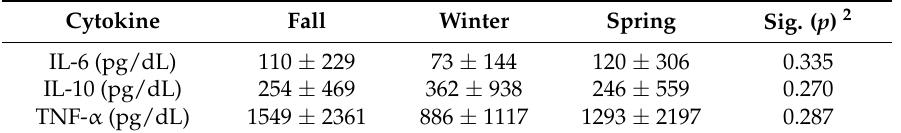
Table 3. Cytokine concentrations across the academic year 1